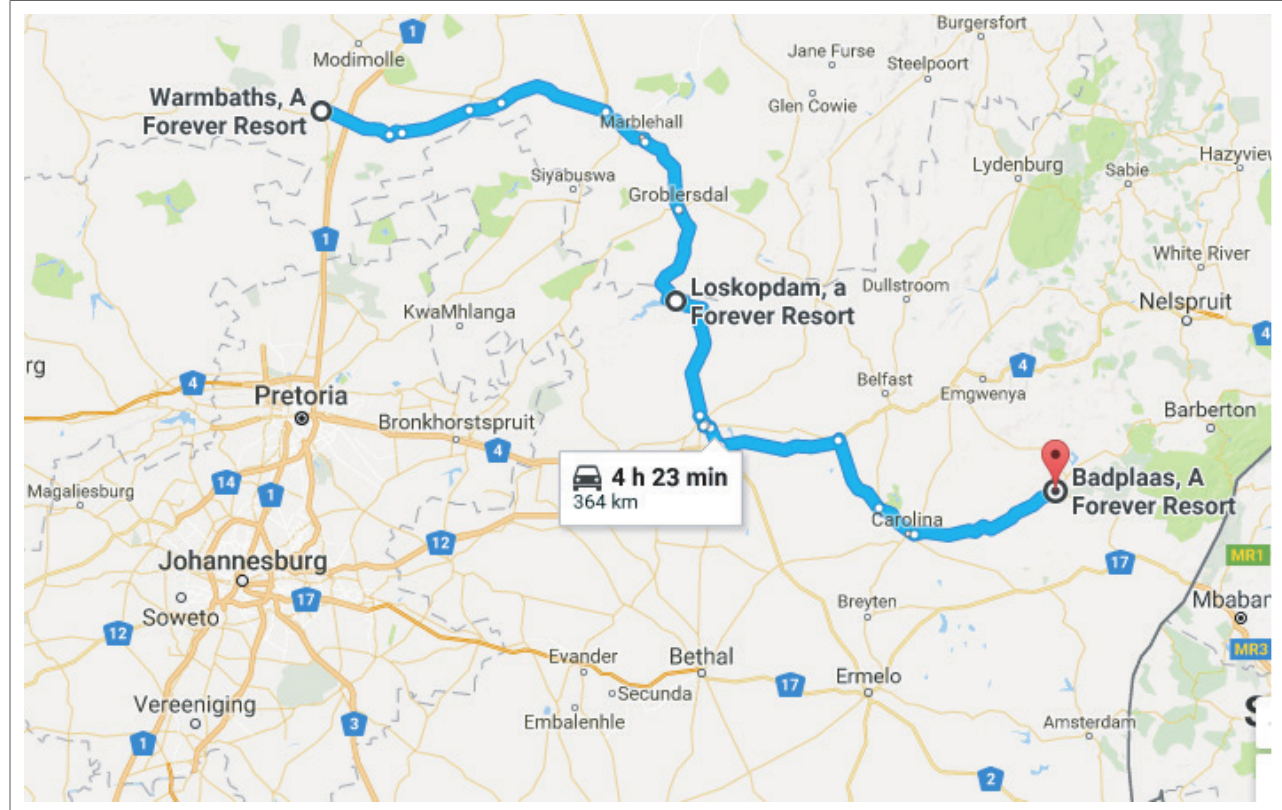
FIGURE 2: Location of Forever Resorts included in the